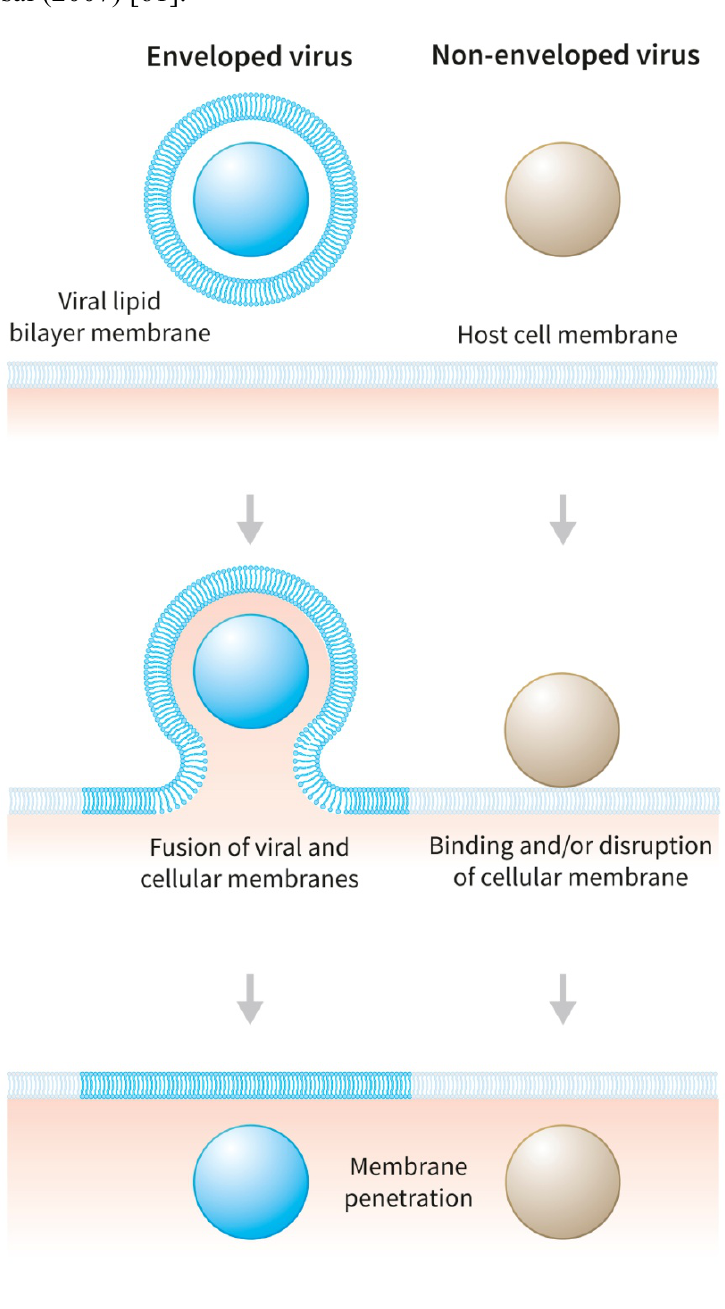
Figure 2. A simplified cartoon representation of the differences in host cell membrane penetration by enveloped and non-enveloped viruses. Enveloped viruses such as influenza and vesicular stomatitis virus enter the cell by receptor mediated endocytosis and fuse their membrane with that of the host cell endosomal membrane using specialized fusogenic proteins which undergo a conformational change in the acidic endosomal environment. In contrast, upon binding to the host cell via specialized receptors, non-enveloped viruses undergo conformational changes in key virally encoded proteins such as protein VI from adenovirus that disrupt the host cell membrane. Host membrane disruption can occur either at the cell surface, as in poliovirus, from an endosome as in adenovirus, from the Golgi as in papillomavirus or from the endoplasmic reticulum as in polyomavirus. Adapted and redrawn from Tsai (2007)